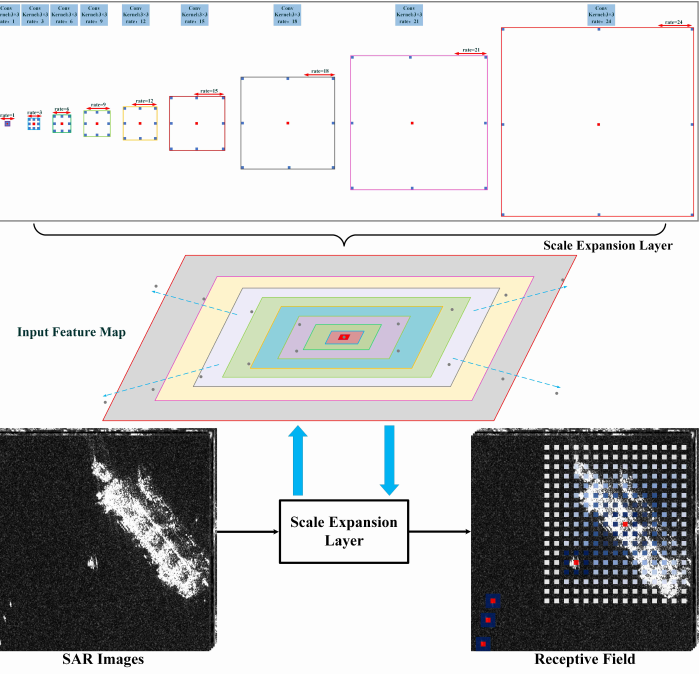
Figure 4. Structure of scale expansion layer. The feature extraction of ultra-small-scale targets and ultra-large-scale targets is realized by changing the receptive field of the scale extension